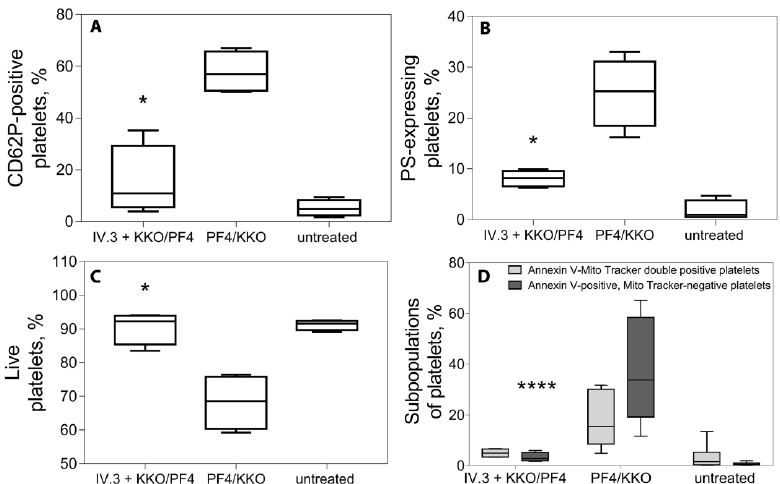
Figure 2. Effects of the mixture of KKO and PF4 on platelets pre-treated with a monoclonal Ab IV.3 against the FcγRII-receptor. Platelets were incubated for 60 min at 37 °C under the following conditions: untreated platelets (negative control), treated with KKO/PF4 (positive control) and treated with KKO/PF4 after pre-treatment for 10 min at 37 °C with a monoclonal Ab IV.3 against the FcγRII-receptor. Final concentrations: 10 µg/mL PF4, 50 µg/mL KKO, 50 µg/mL IV.3. ( A ) Fraction of platelets expressing P-selectin (CD62P-positive). ( B ) Fraction of platelets expressing phosphatidylserine (Annexin V-positive). ( C ) Fraction of live platelets with normal mitochondrial membrane potential determined with a ∆Ψ m-sensitive (mitochondrial membrane potential) dye MitoTrackerDeepRed. ( D ) Subpopulations of platelets double-stained with a ∆Ψ m-sensitive dye MitoTrackerDeepRed and FITC-Annexin V normalized by the total number of gated platelets taken as 100%. Platelets were segregated into 2 subpopulations: MitoTracker-negative / Annexin V-positive or “dead platelets” (dark boxes) and MitoTracker-positive / Annexin V-positive or “live activated platelets” (light boxes). Each experiment was performed with platelets isolated from three independent donors. * p < 0.05, **** p < 0.0001 for the corresponding data without and with the addition of Ab IV.3 (A-C, Kruskal–Wallis test; D, 2-way ANOVA test with Dunn’s post-hoc